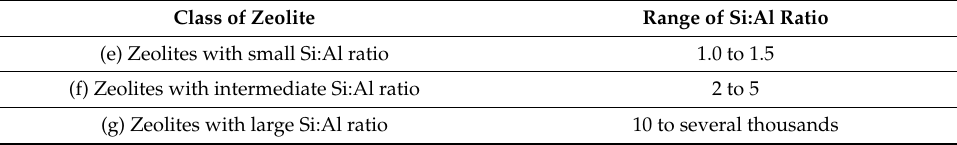
Table 4. Classification of zeolites considering Si to Al ratio.